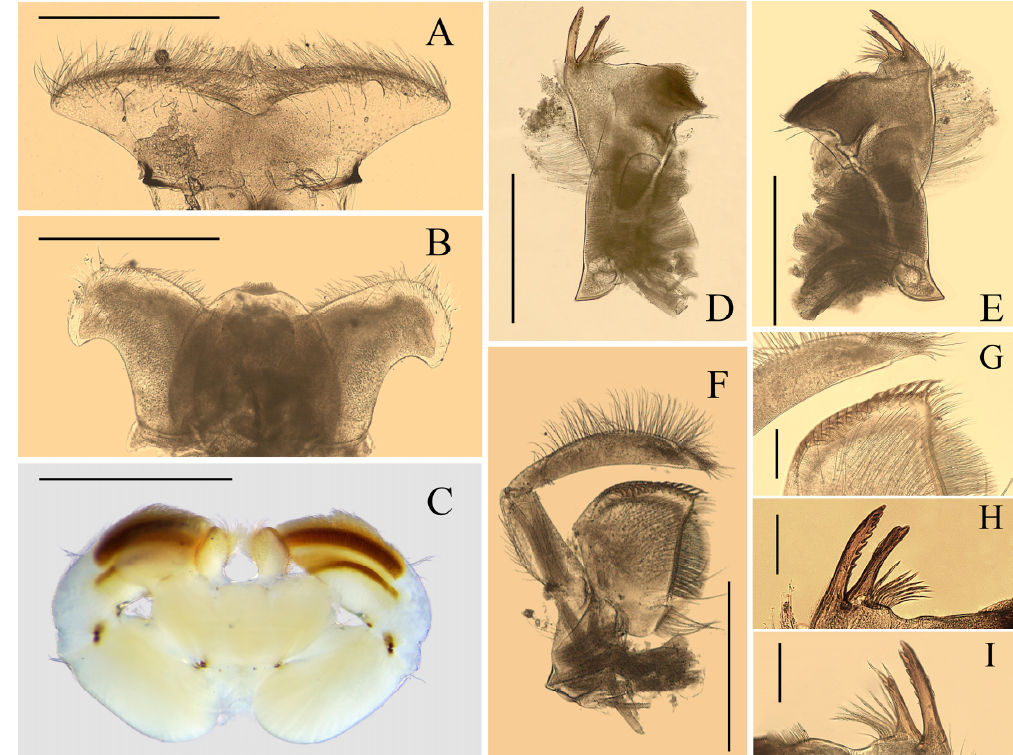
Figure 2. Mouthparts of Regulaneuria cingulata : ( A ) Labrum (ventral view); ( B ) Hypopharynx (ventral view); ( C ) Labium (ventral view); ( D ) Left mandible (ventral view); ( E ) Right mandible (ventral view); ( F ) Maxillae; ( G ) Apex of maxillae; ( H ) Incisors of left mandible; ( I ) Incisors of right mandible. Scale bars: ( A , B , D – F ) = 0.5 mm; ( C ) = 1.0 mm; ( G ) = 0.2 mm; ( H , I ) = 0.1 mm.